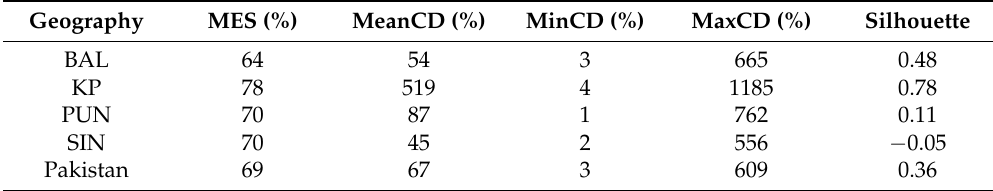
Table 7. Performance of CLOPE for Event–Method clustering (countrywide and provincially); MES = mean element similarity (%), MeanCD = mean cluster distance (%), MinCD = minimum cluster distance (%), MaxCD = maximum cluster distance